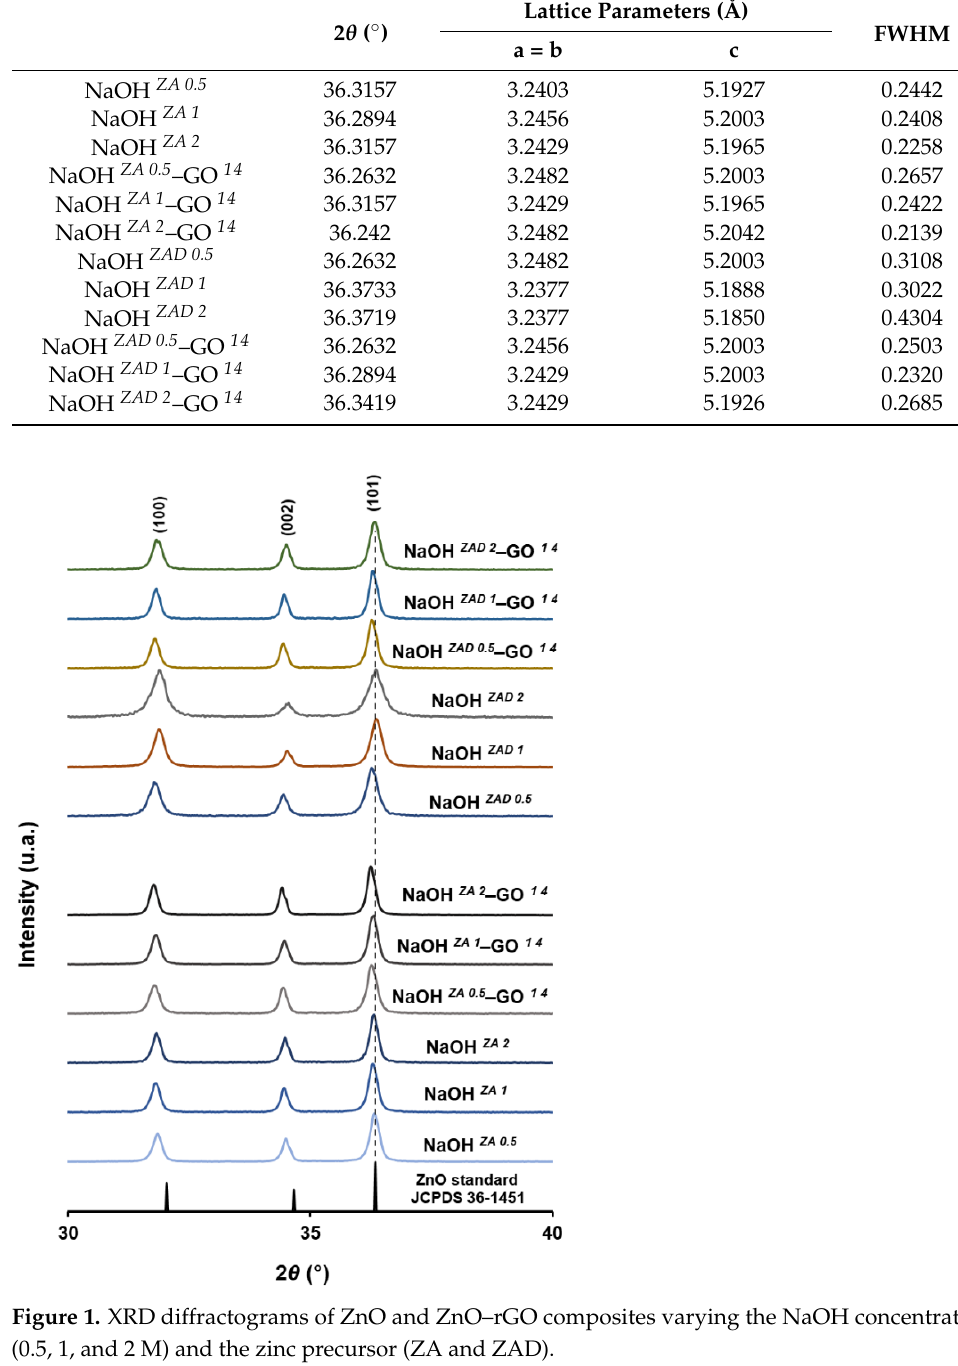
Table 2. Peak position of (101) plane present in the XRD diffractograms of ZnO and ZnO–rGO composites varying the NaOH concentration and the zinc precursor. The respective lattice parameters and the FWHM are also presented. 2 θ (°)